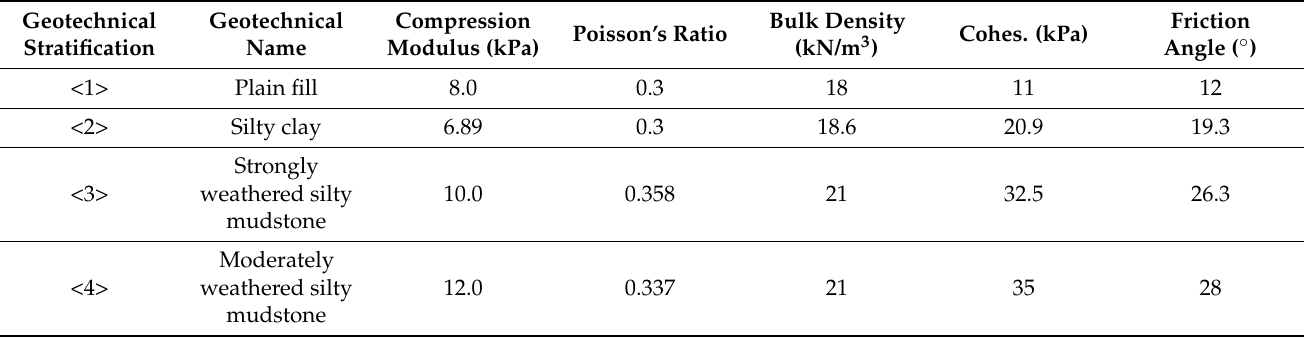
Table 1. Parameter table of formation physical and mechanical